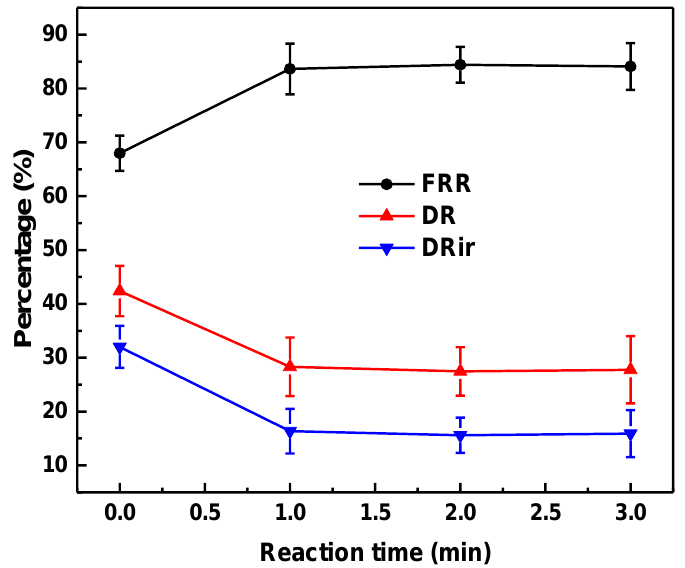
Figure 5. Effect of reaction time between TA and FeIII on antifouling performance. Feed: H 2 O/diesel (99/1) emulsion at 1 bar.